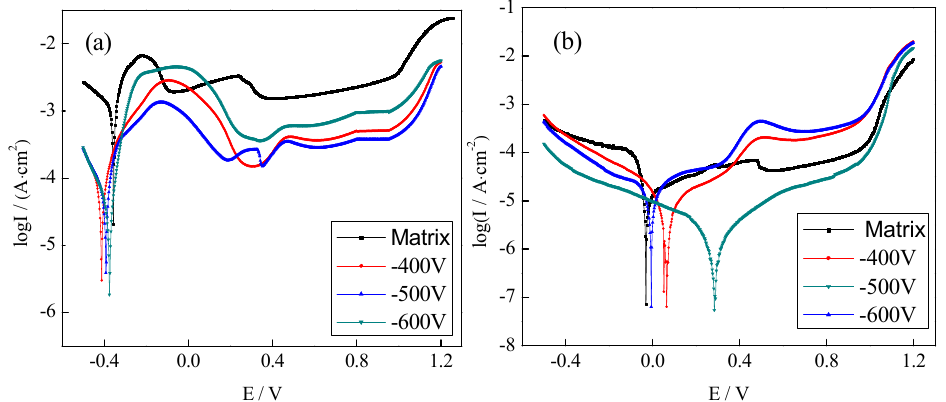
Figure 5. Potentiodynamic polarization curves of the plasma-nitrided coating in the working environment of the PEMFC bipolar plate (( a ) cathodic working environment, ( b ) anodic working environment).